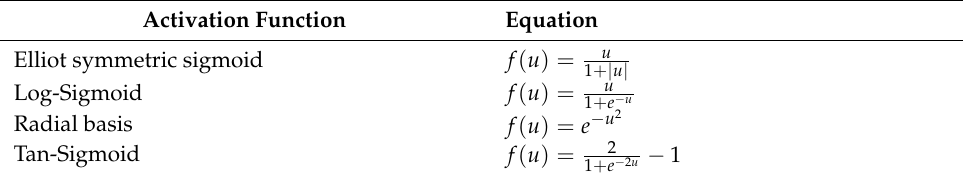
Figure 5. MLP Feedfoward Neural Network Architecture. Table 3. Activation